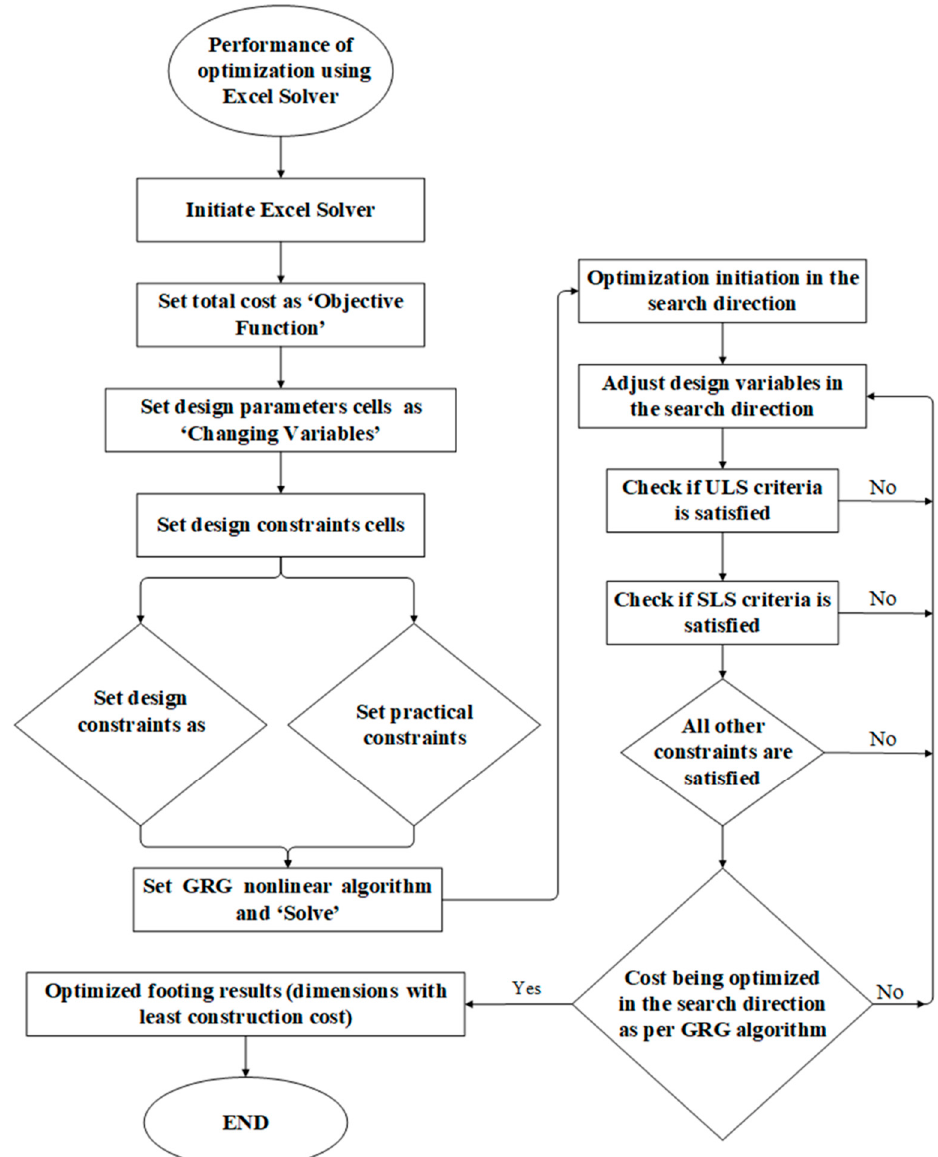
Figure 2. Procedure of GRG algorithm for foundation optimization.